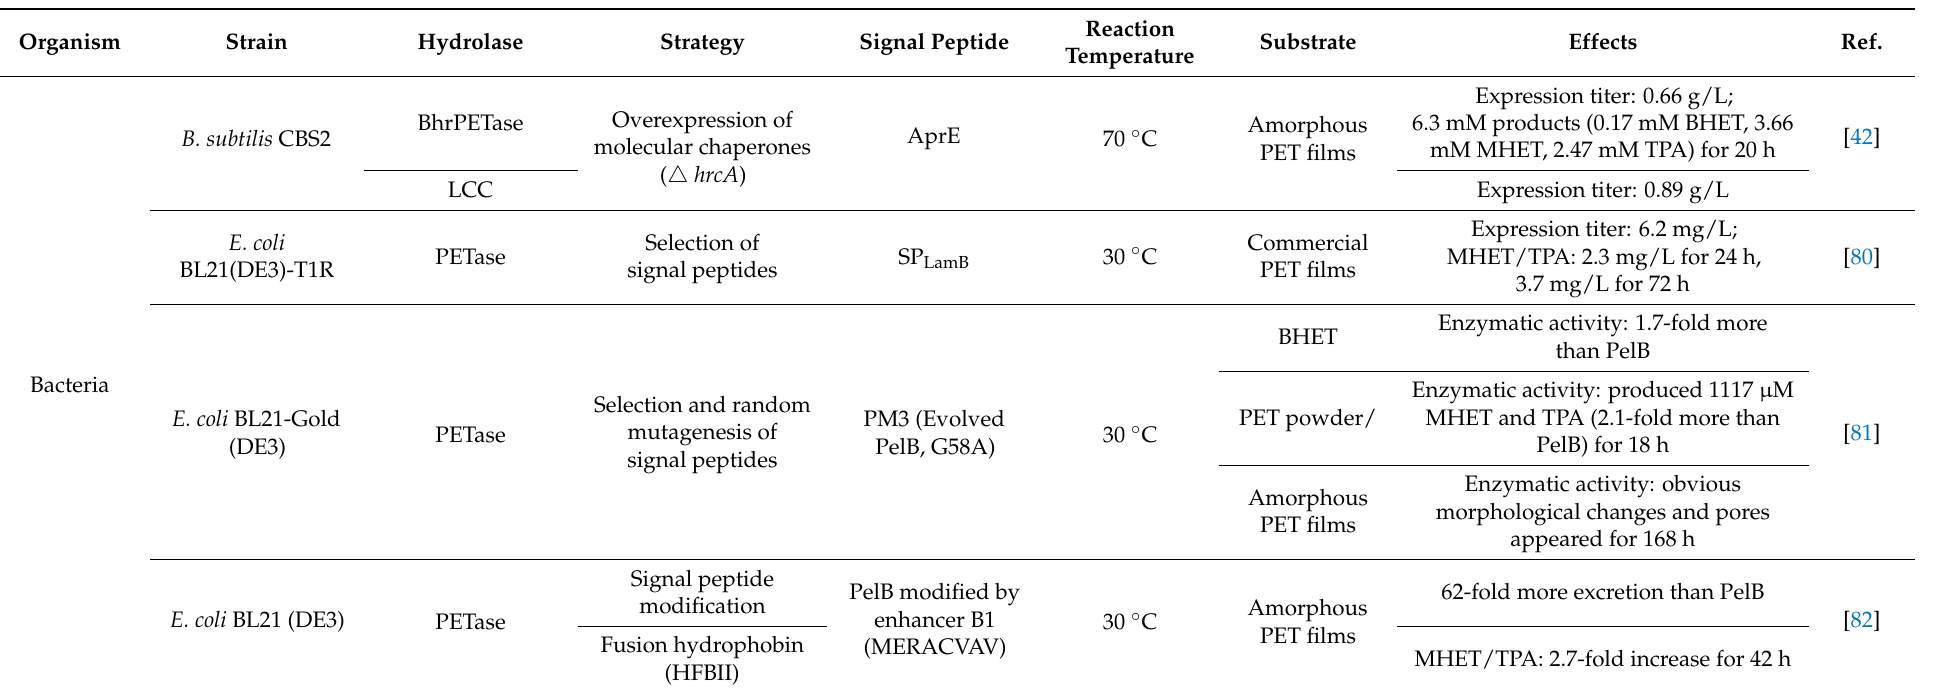
Table 2. Engineered microbial chassis for PET